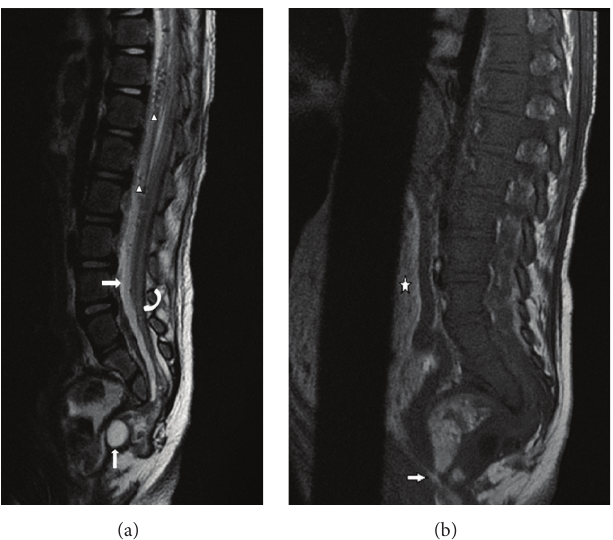
Figure 4: Spine MRI on day 5 to further characterize the presacral mass. (a) Sagittal T2 weighted MR image of the lower spine shows complex presacral mass with a small separate hyperintense cyst communicating with the thecal sac, which could be meningocele (thin arrow). Spinal canal shows epidural fluid collection (arrow) with multiple air foci (arrowheads). There is low-lying conus and a tethered cord, reported in